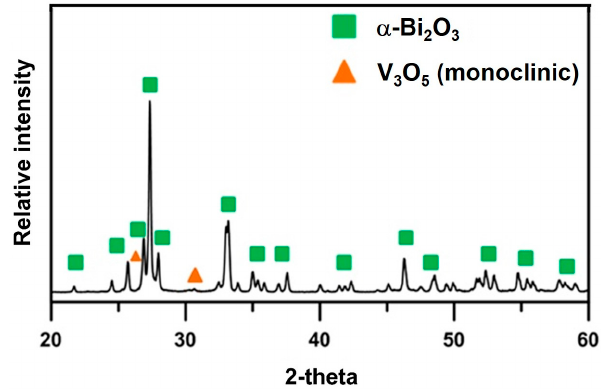
Figure 3. X-ray diffraction (XRD) result of B1V die-pressed mixture after calcination at 350 °C for 24 h. The V 3 O 5 is indexed by JCPDF 71-39.